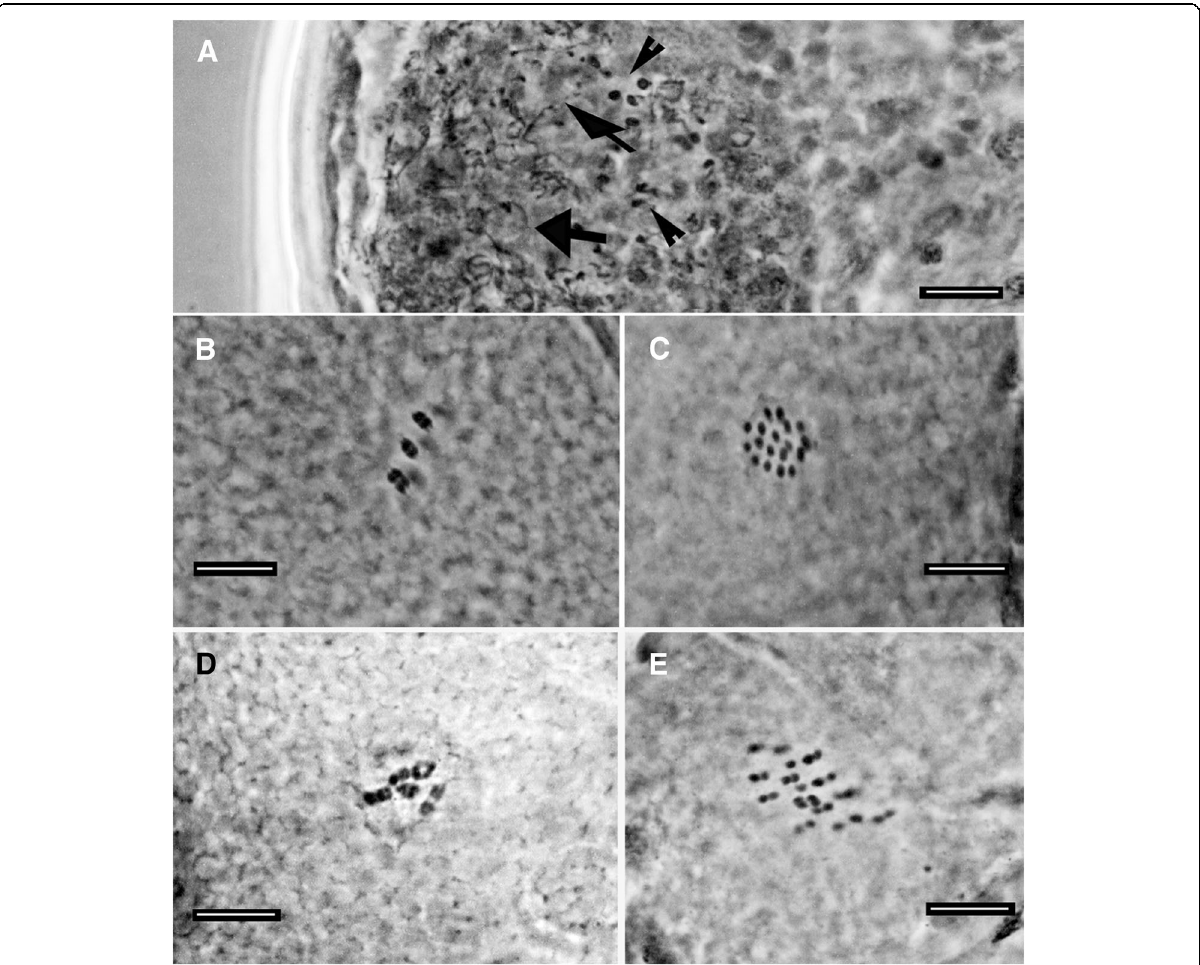
Fig. 11 Male germ cells and chromosomes (orcein; PhC). a Testis with spermatids (arrowheads) and spermatozoa (arrows) of a male from Passo Ballino. b Bivalents in an oocyte of a female from Passo Ballino. c 18 univalents in an oocyte of a female from Rocchetta. d Bivalents in an oocyte of a female from Ospitaletto A. e Univalents in an oocyte of a female from Ospitaletto B. Bars = 10 μ